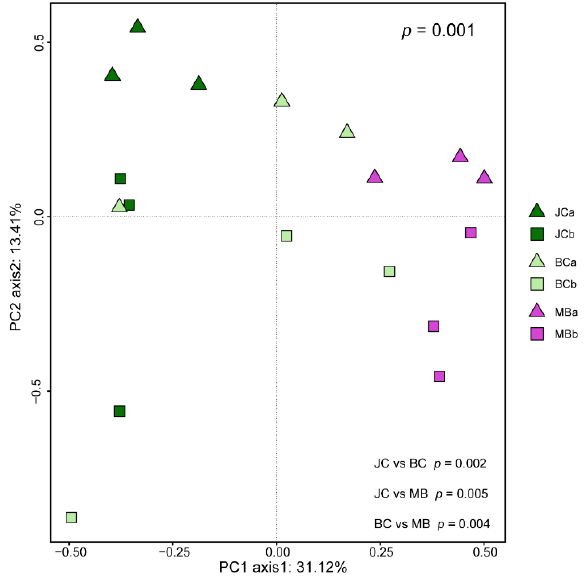
Figure 3. Principal component analysis (PCA) of the AMF community (represented by OTUs). Note: JCa and JCb are 0 − 10 cm soil layer and 10 − 20 cm soil layer of Japanese cedar, respectively; BCa and BCb are 0 − 10 cm soil layer and 10 − 20 cm soil layer of bamboo–cedar mixed, respectively; MBa and MBb are 0 − 10 cm soil layer and 10 − 20 cm soil layer of moso bamboo, respectively.